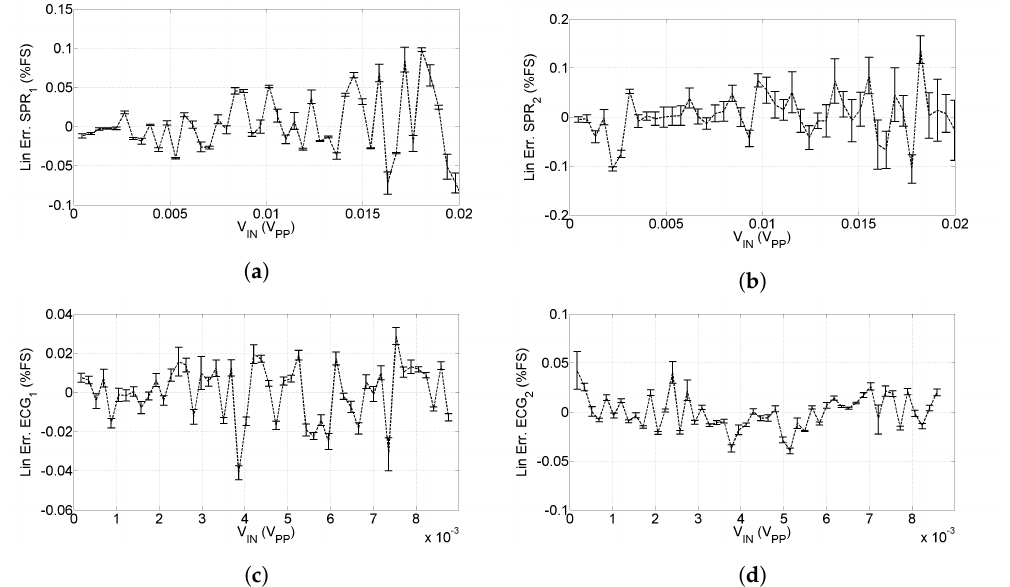
Figure 5. Linearity of the developed sensors, error bars represent the uncertainty on linearity. ( a ) Linearity for SPR 1 signal, ( b ) Linearity for SPR 2 signal, ( c ) Linearity for ECG 1 signal, and ( d ) Linearity for ECG 2